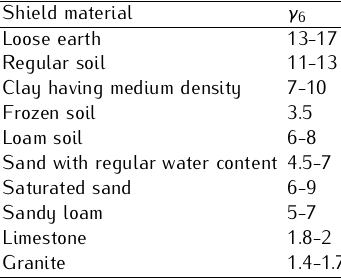
for typical soils. Table 5. Parameter γ 4